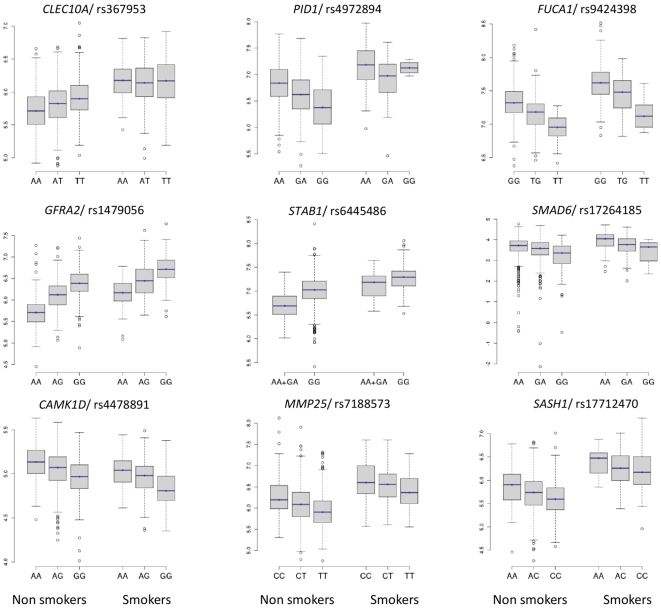
Effect of the best cis eSNP and smoking on expression of smoking-related eQTLs.The proportion of variability of expression explained by the best cis eSNP varied from 3.1% for CLEC10A to 27.2% for GFRA2 while the proportion explained by smoking varied from 2.8% for SMAD6 to 21.6% for SASH1. The lowest P-value for interaction between SNP and smoking was 0.02 for STAB1.